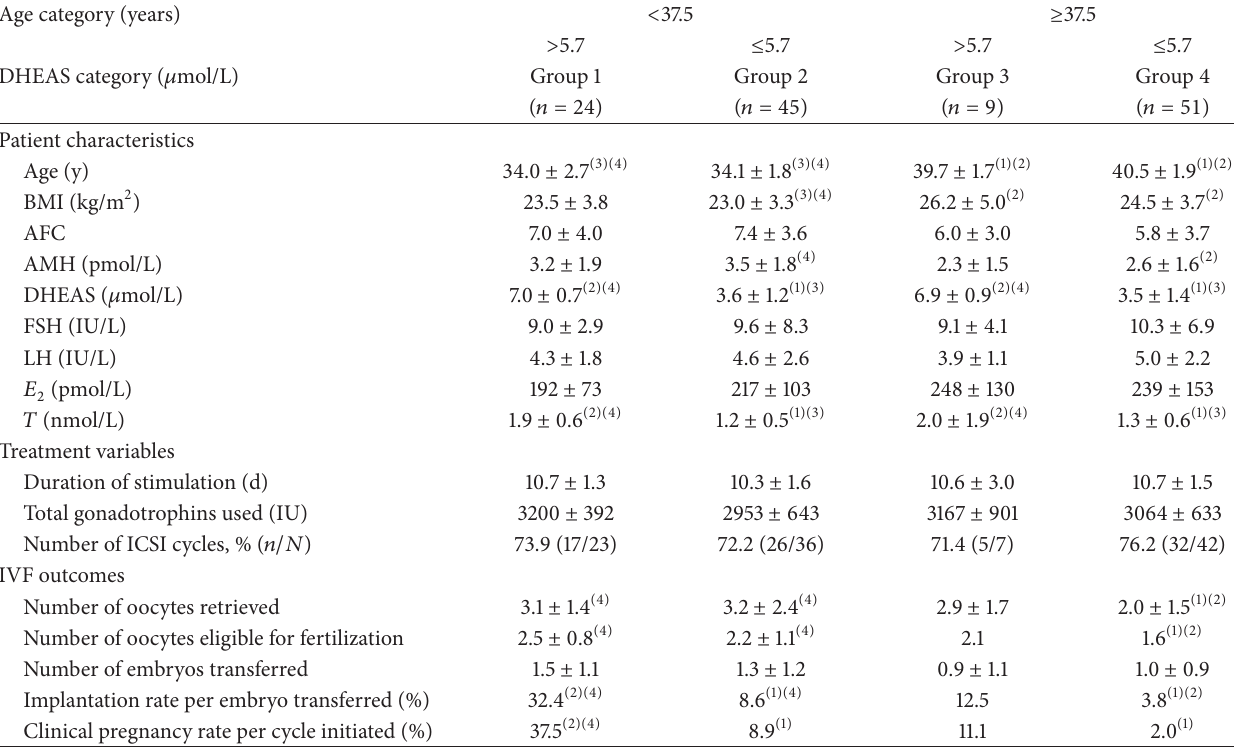
Table 3: Baseline patient characteristics, treatment variables, and IVF outcomes of the patients grouped according to the cut-off values for female age and DHEAS level predictive of clinical pregnancy (cutoffs are selected by ROC curve